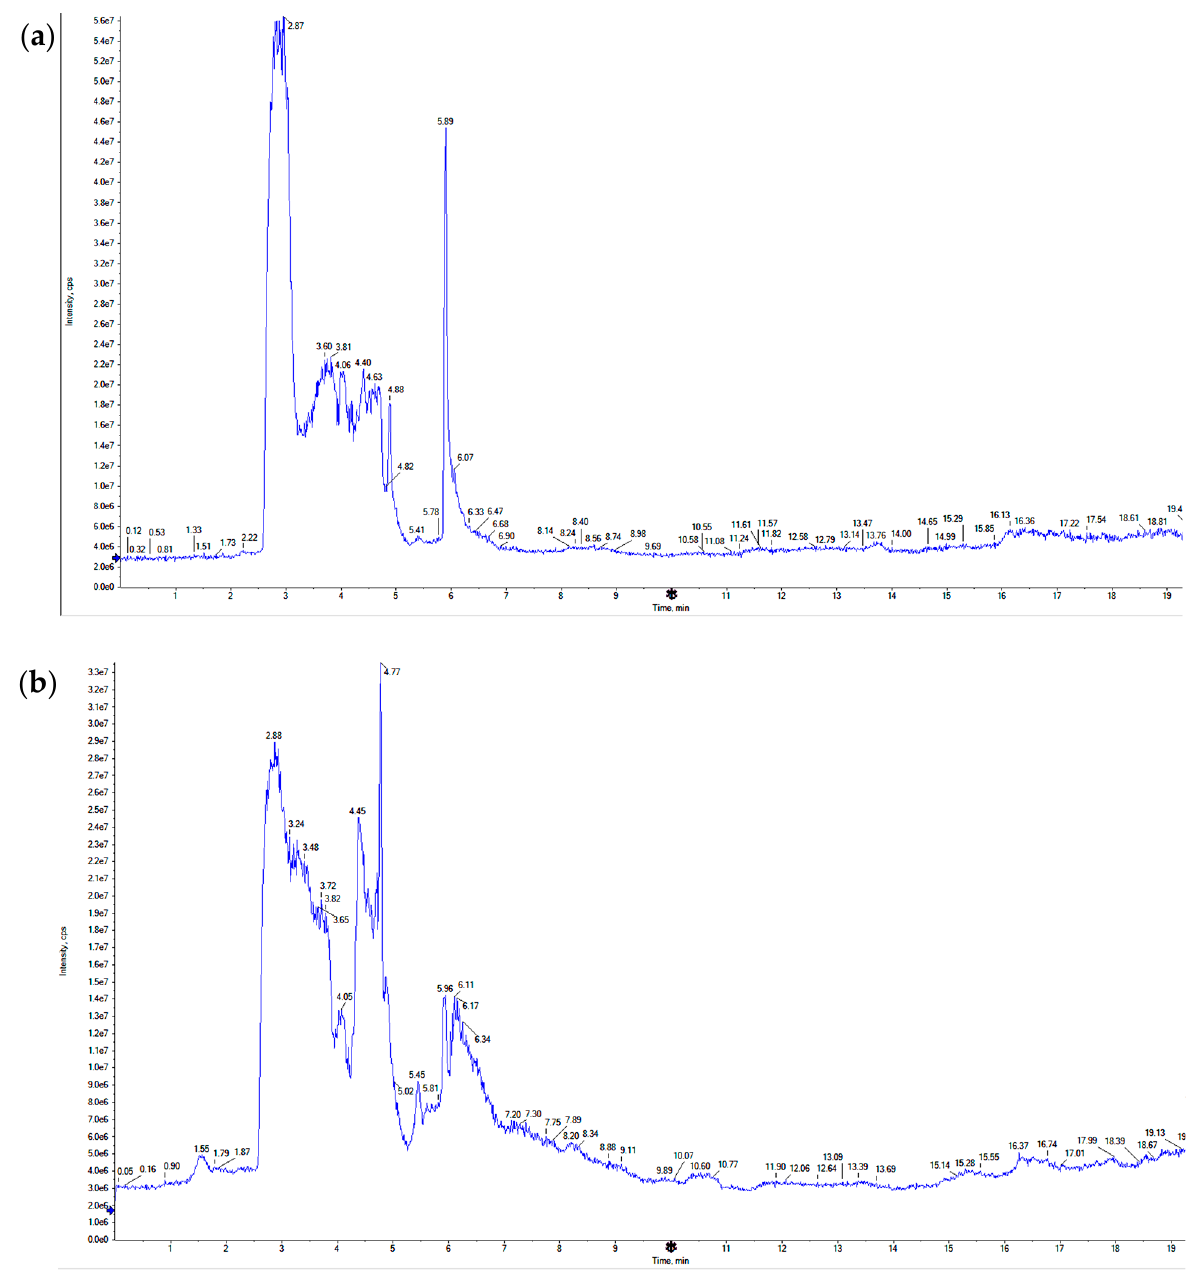
Figure 1. LC-TOF-MS analysis of CARD aqueous extract. ( a ) Positive mode MS chromatogram. ( b ) Negative mode MS chromatogram.